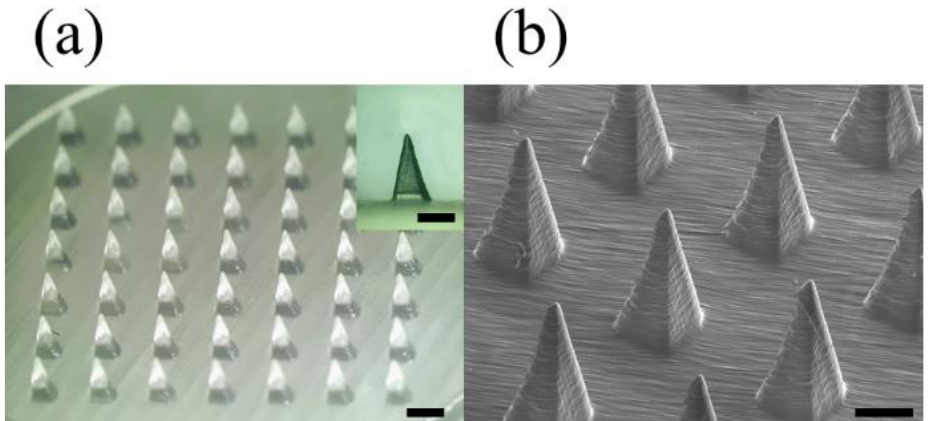
Figure 4. The 3D printed microneedle mold array measured by a stereomicroscope ( a ); the scale bar in the inset image and the bottom scale bar are 0.5 mm and 1.0 mm, respectively. SEM ( b ); scale bar is 0.5 mm. The microneedle mold array consisting of 7 × 7 microneedles was printed at the optimized condition with 60° printing angle to the x and y axes, 2.6:1 aspect ratio (input height 1300 µm, base 500 µm), and 1000 µm spacing between the microneedles.